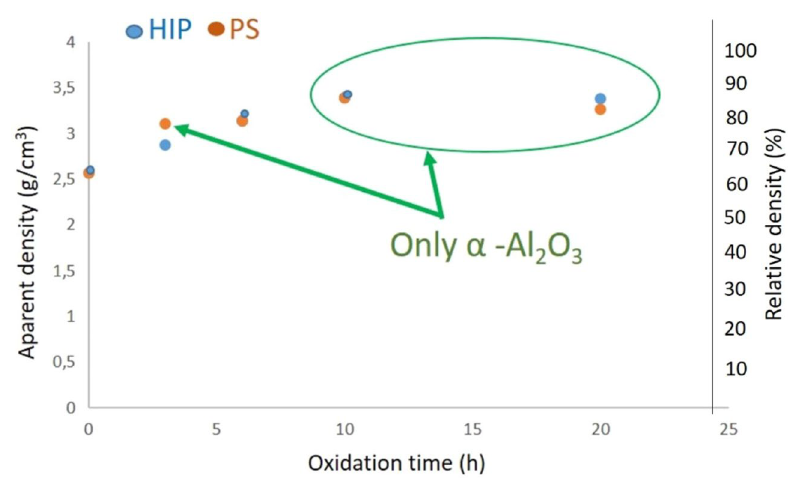
Figure 9. Apparent and relative density measurements of the HIP and PS